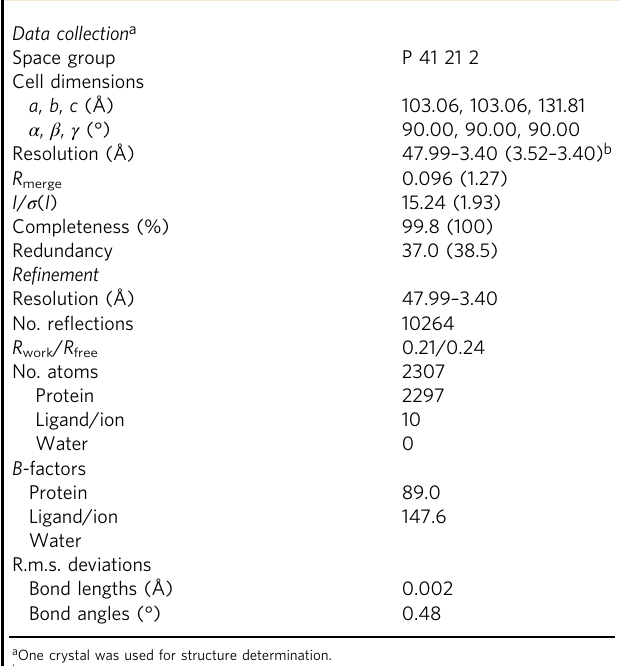
Table 1 Data collection and re fi nement statistics for SPOP- MATH-Geminin peptide (PDB entry